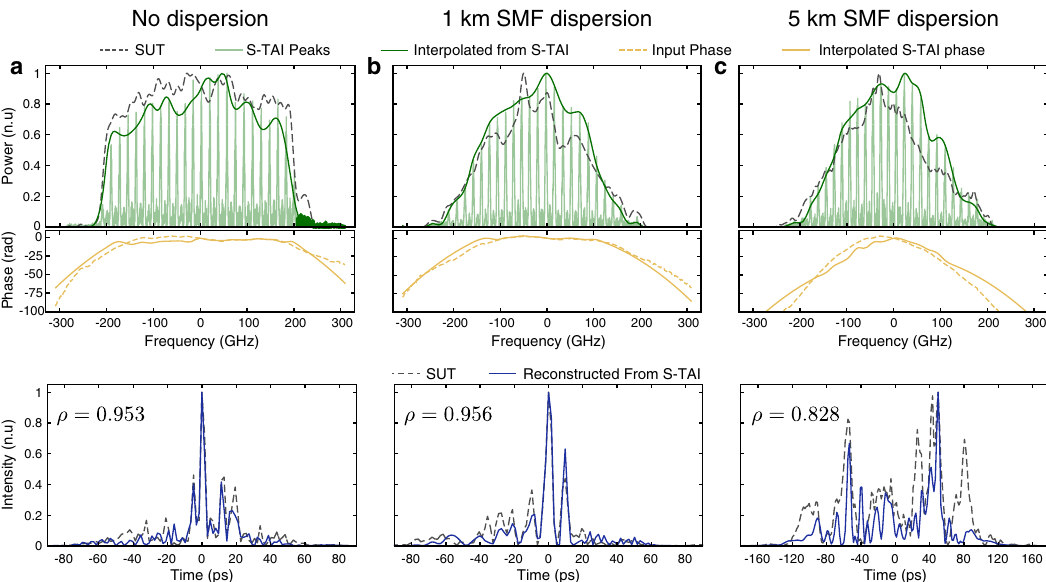
Fig. 4 Temporal waveform recovery from the S-TAI output. The temporal waveform can be recovered by interpolating the amplitude and phase from the peaks of the output waveform. The spectral phase pro fi le of each relevant waveform was retrieved using Fourier-transform spectral interferometry (FTSI) 32 . The signals under test (SUTs) are picosecond-resolution waveforms that undergo a no dispersion, b dispersion after propagation through a 1-km- long section of standard optical fi ber and c through a 5-km-long section of fi ber. (Top) The recovered spectral waveform with (middle) the recovered spectral phase and (bottom) the reconstructed temporal intensity pro fi les. As measured by the cross-correlation coef fi cient ρ , the recovered S-TAI temporal waveforms show excellent agreement with the measured input temporal waveforms. The S-TAI was designed for q = 5, ν s = 3.5 GHz and ν = 17.4 GHz. Each of the shown temporal and spectral intensity waveforms is normalized to unity for q